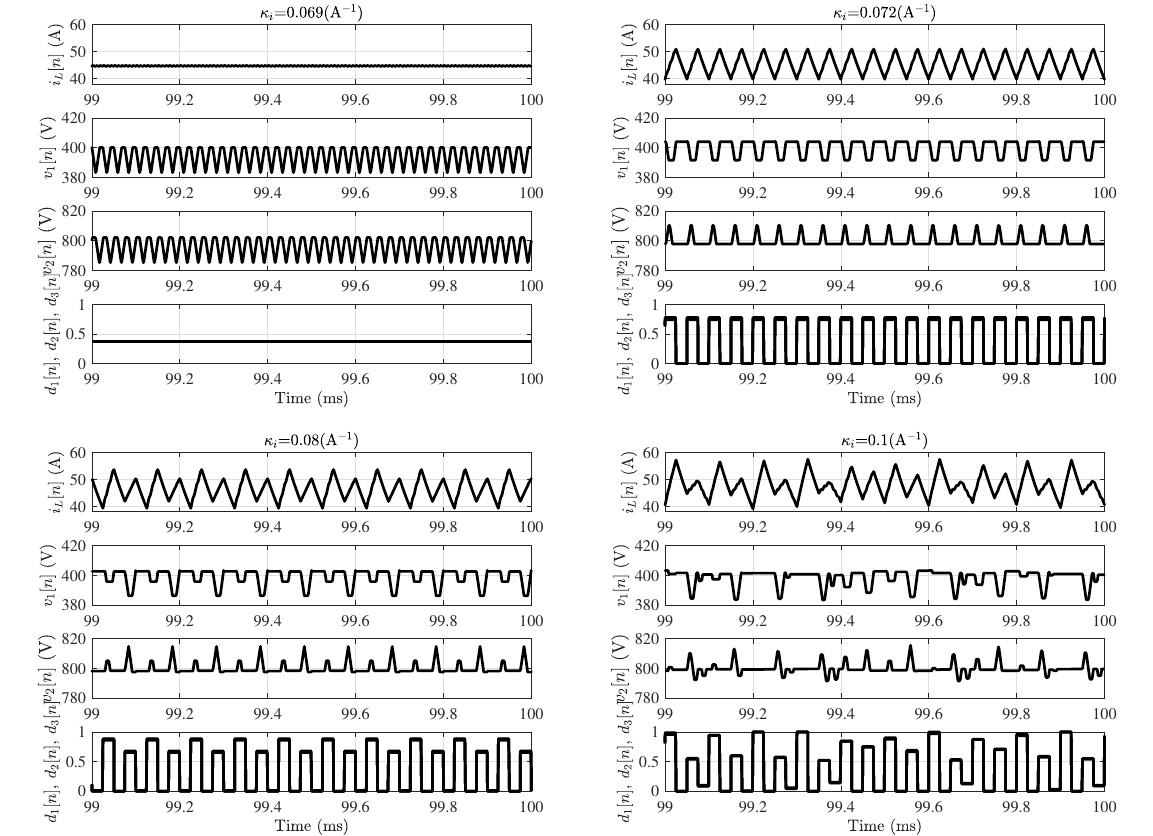
Figure 6. Time-domain waveforms for different values of κ i that are indicated in each panel title. i ref = 50